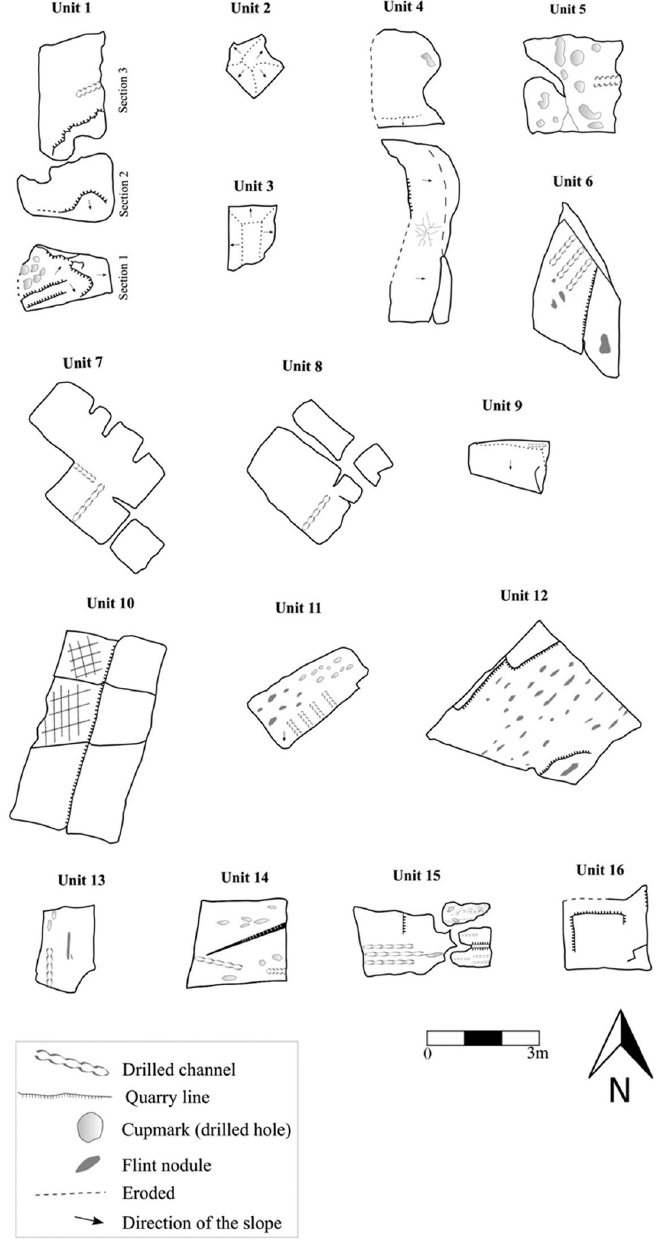
Fig 15. The rock damaged 16